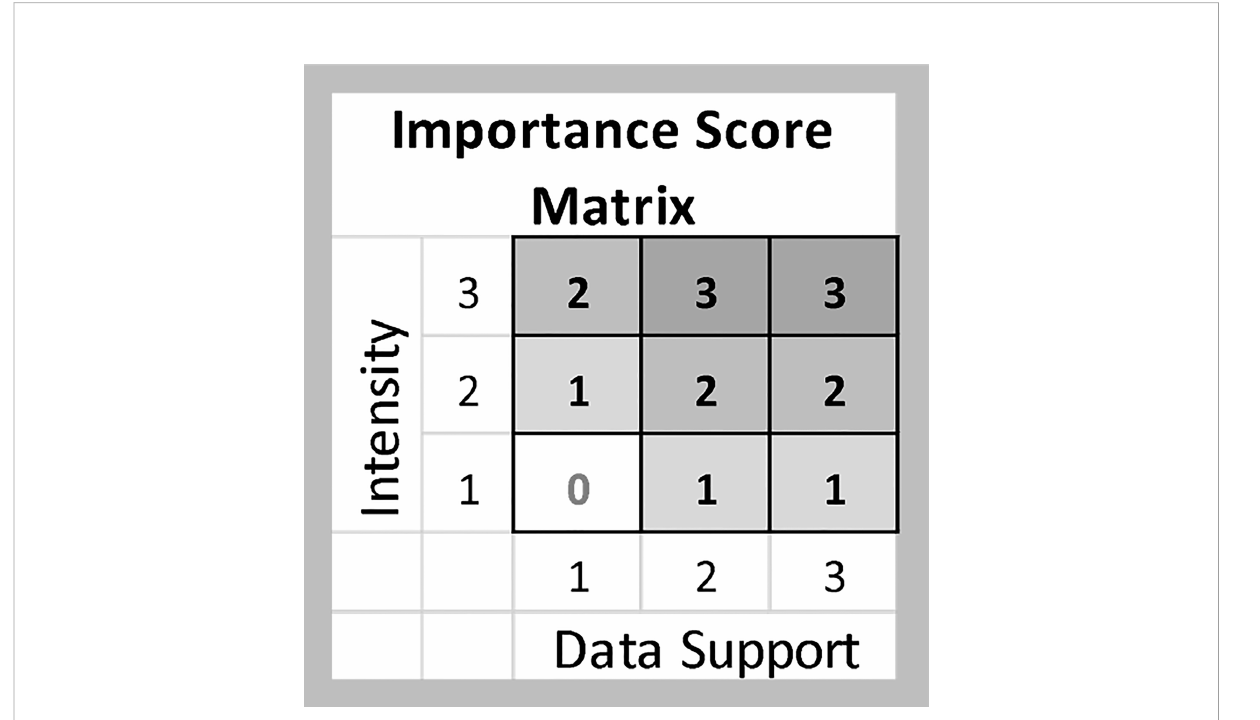
FIGURE 2 Matrix used to combine Intensity and Data Support to identify